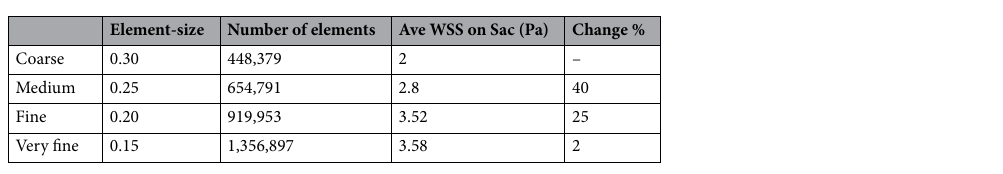
Table 2. Details of used